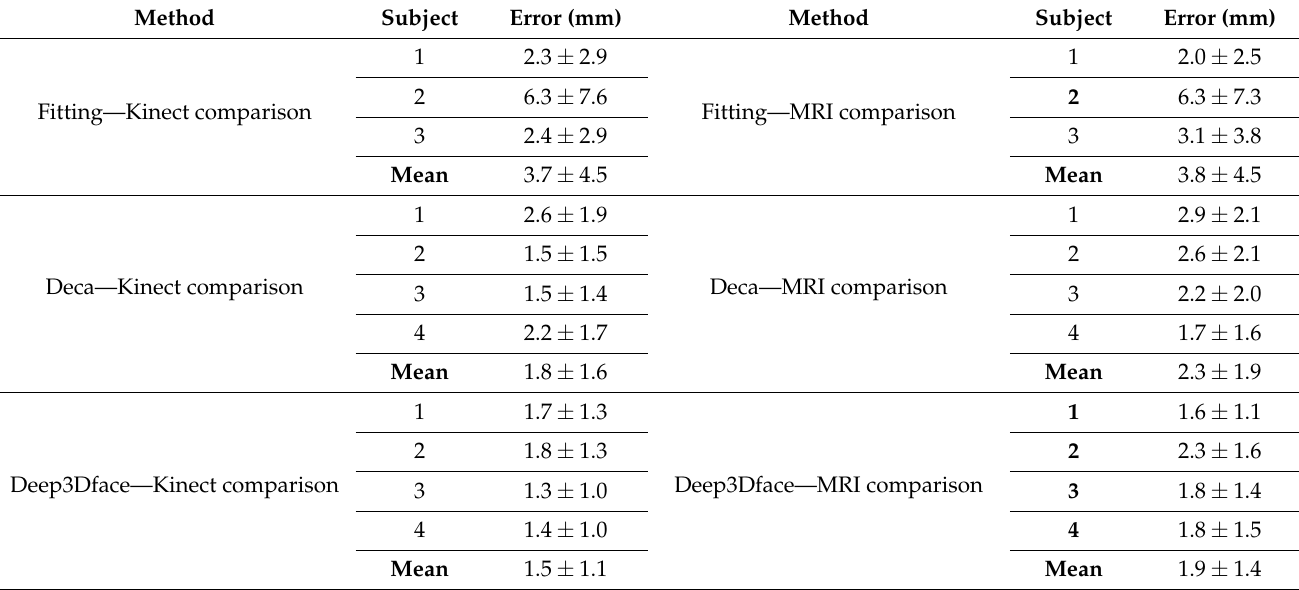
Table 1. Reported error ranges of 3D faces reconstructed using the methodology compared to the 3D faces reconstructed by Kinect and MRI techniques for the validation study.